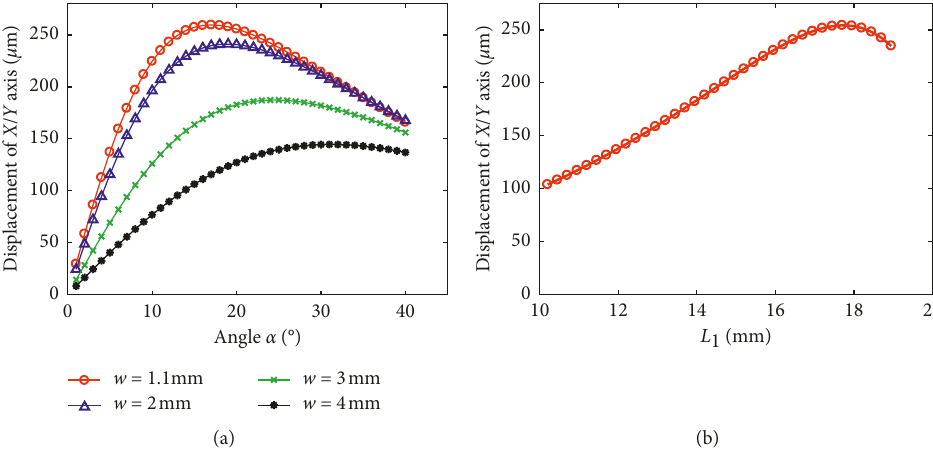
Figure 11: Dependence of the maximum translational displacement on the designed parameters.